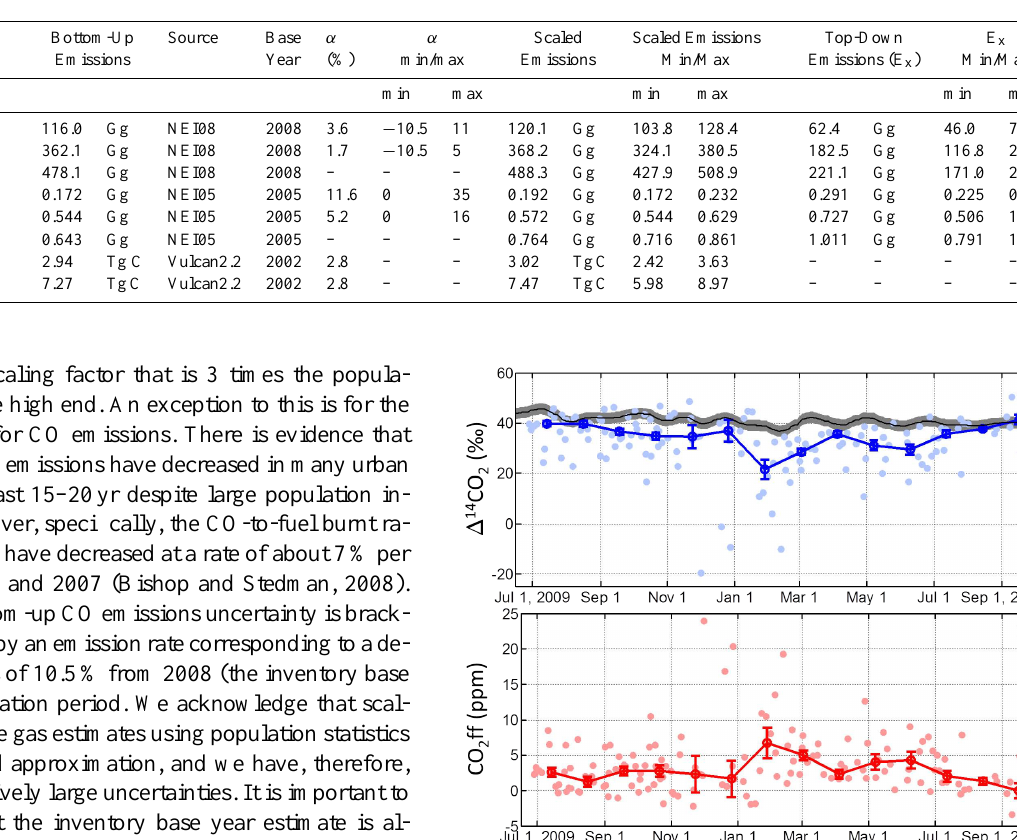
Table 3. Summary of top-down and bottom-up annual emissions for CO and C 2 H 2 , including the bottom-up emission source, inventory base year, the scaling term ( α ), and associated uncertainties derived for different regions around the sampling site in Colorado for the measurement period. Bottom-up emissions for CO 2 ff are also summarized. Uncertainties on the scaled bottom-up emissions and the top-down emissions are described in Sects. 3.3 and 3.3.1.